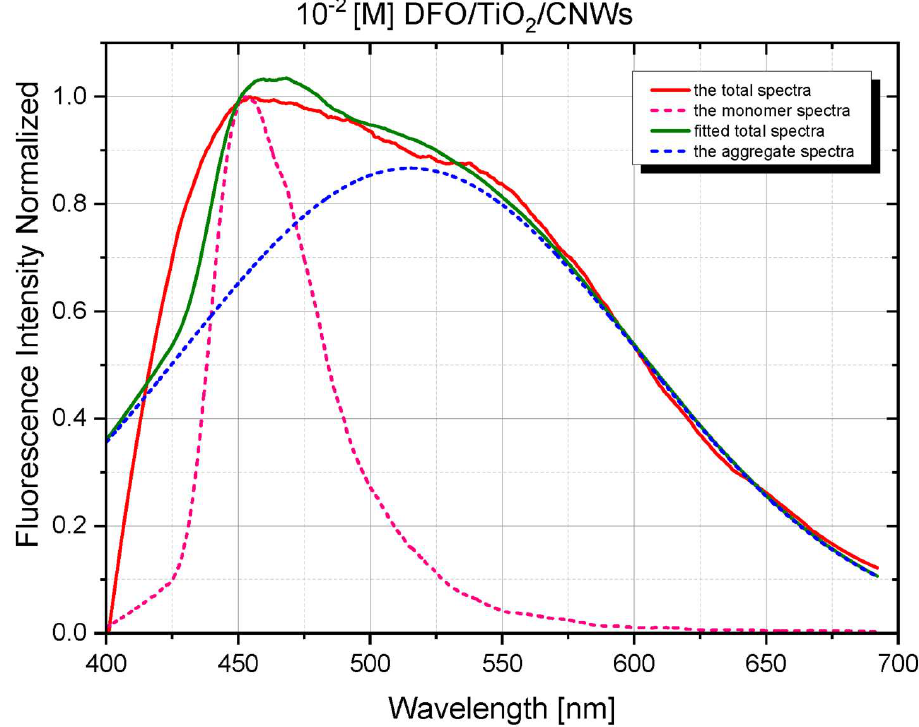
Figure 6. Numerically deconvoluted fluorescence spectra of DFO/TiO 2 /CNW monomers and aggregates, the measured total fluorescence spectrum at c = 10 –2 [M], and the numerical